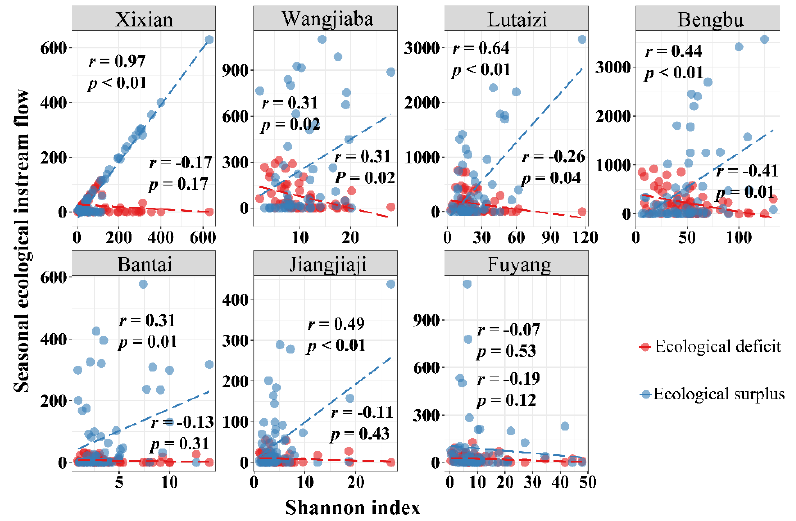
Figure 12. The correlation between seasonal ecological instream flow and Shannon index.